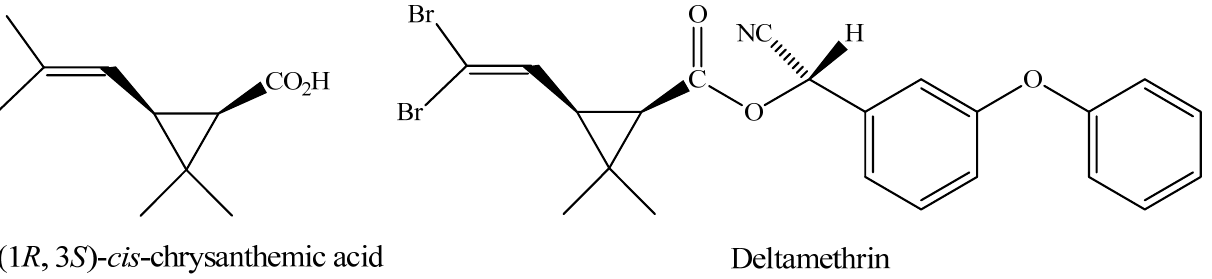
Figure 1. Structure of the (1 R , 3 S )- cis -chrysanthemic